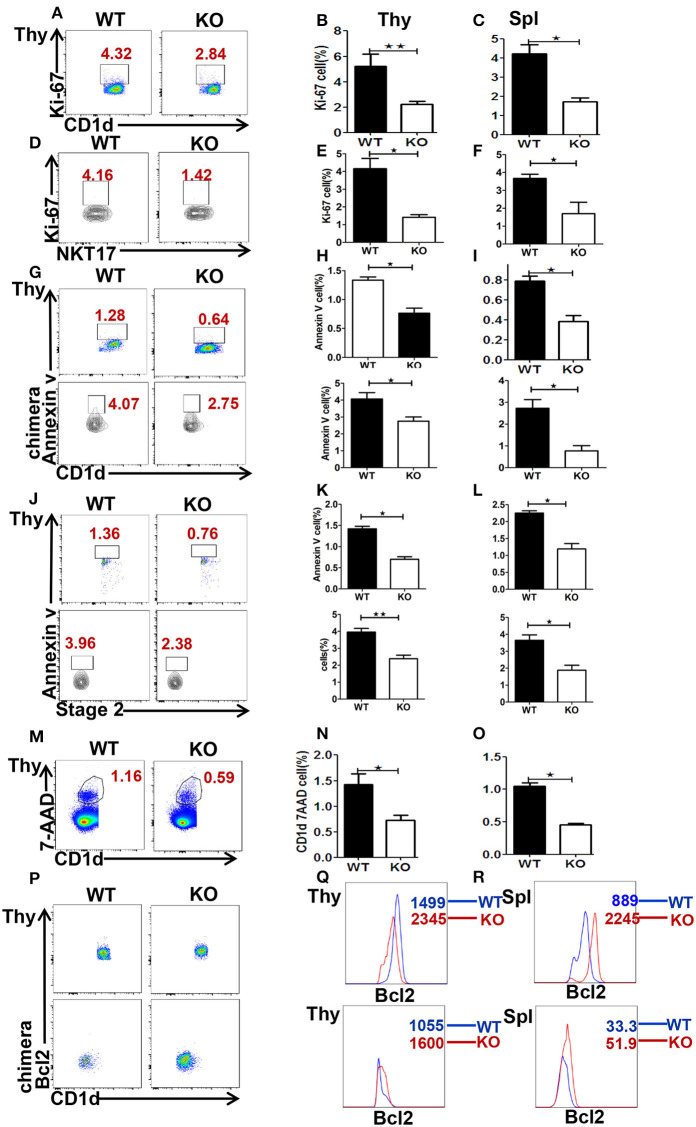
Loss of Akt2 reduces the proliferation and apoptosis of iNKT cells. (A) Flow cytometry of Ki-67 cells gated on iNKT cells in the thymus. (B,C) Percentage of Ki-67 cells in the thymus and spleen (n = 3 mice per group). (D) Flow cytometry of Ki-67 cells gated on NKT17 cells in the thymus. (E,F) Percentage of Ki-67 cells gated on NKT17 cells in the thymus (n = 3 mice per group) and spleen (n = 3 mice per group). (G) Flow cytometry of Annexin V cells gated on the iNKT in the thymus. (H,I) Percentage of Annexin V cells in the thymus and spleen of WT (n = 3), KO (n = 3), WT chimera mice (n = 4) and Akt2 KO chimera mice (n = 3). (J) Flow cytometry of Annexin V cells gated on the stage2 (CD24−CD44+NK1.1−) iNKT cells in the thymus of WT, KO, and chimera mice. (K,L) Percentage of Annexin V cells of stage2 iNKT cells in the thymus and spleen of WT (n = 3), KO (n = 3), WT chimera mice (n = 4), and Akt2 KO chimera mice (n = 3). (M) Flow cytometry of CD1d cells gated on 7AAD cells in the thymus. (N,O) Percentage of CD1d cells in the thymus (n = 3 mice per group) and spleen (n = 3 mice per group). (P) Flow cytometry of Bcl2 cells gated on iNKT cells in the thymus. (Q,R) Overlaid histograms show expression of Bcl2.chimera *p < 0.05; **p < 0.01, Student's t-test.